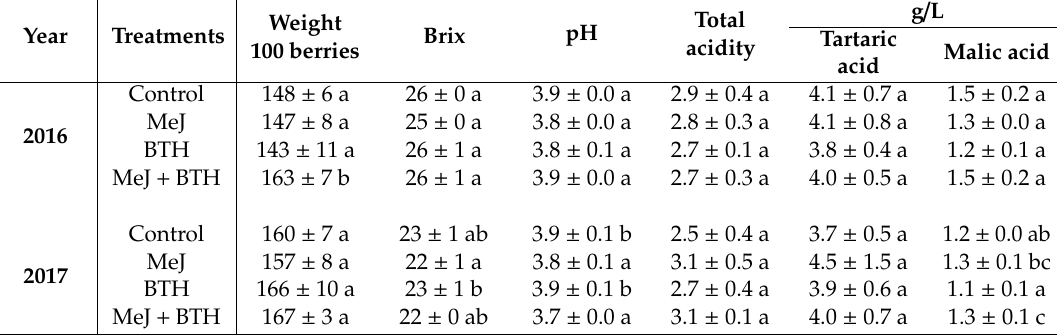
Table 2. Physicochemical characteristics of grapes at